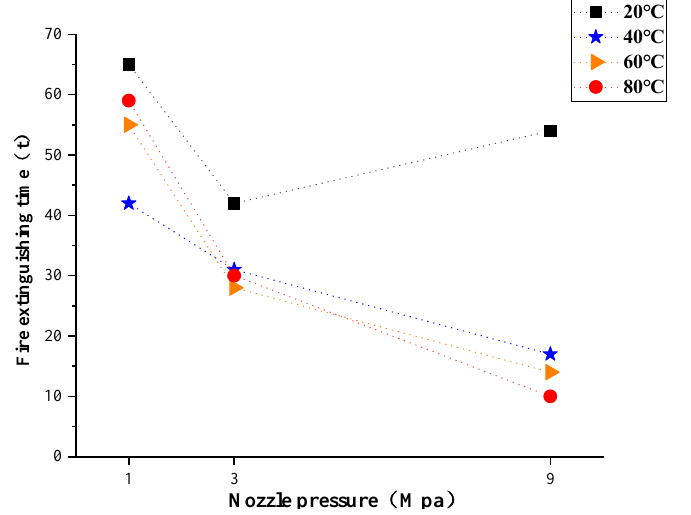
Figure 6. Extinguishing time of n-heptane pool fire by water mist at various temperatures. The fire extinguishing mechanism of pure cold water mist mainly includes gas-phase cooling, attenuation of heat radiation, surface cooling, and oxygen isolation [22]. The fire extinguishing mechanism of hot water and fine water mist is different. When the cooling action is carried out, in other words, the heat absorbed by the water during gasification is much greater than when the water temperature rises. For example, the heat required for 1 kg of water to increase from 20 to 100 ◦ C is 80 kcal, while the heat required for 1 kg to be gasified at 100 ◦ C is 539 kcal. Therefore, the temperature gap leads hot water mist to vaporize faster in fire extinguishing experiments and requires a large amount of heat during gasification, resulting in a faster drop in the fire temperature. The cold water mist does not reach the saturation temperature, and no phase change is happening. When the asphyxiation is performed, the hot water reaching the boiling point is continuously vaporized and heated into a large amount of water vapor. Therefore, it